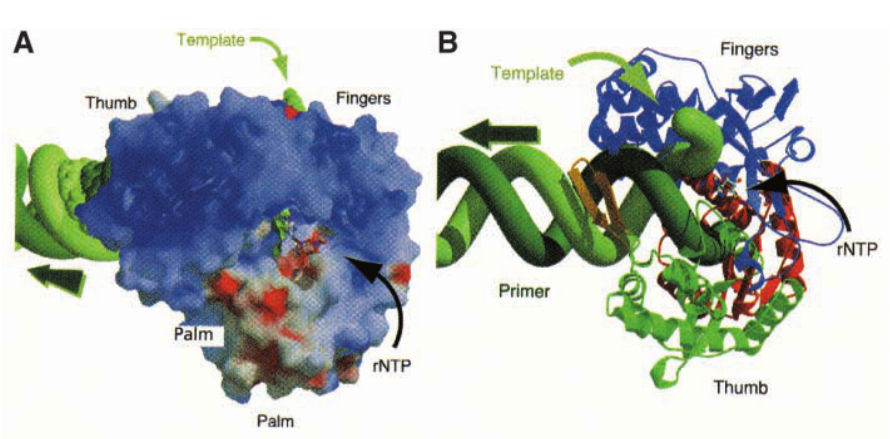
Genetic organization and polyprotein pro- cessing of HCV. As- terisks in the E1 and E2 region indicate glycosylation of the envelope proteins. Diamonds denote cleavages of the HCV polyprotein precursor by the endoplasmic reticulum signal pep- tidase, and arrows indicate cleavages by HCV NS2-3 and NS3 proteases.